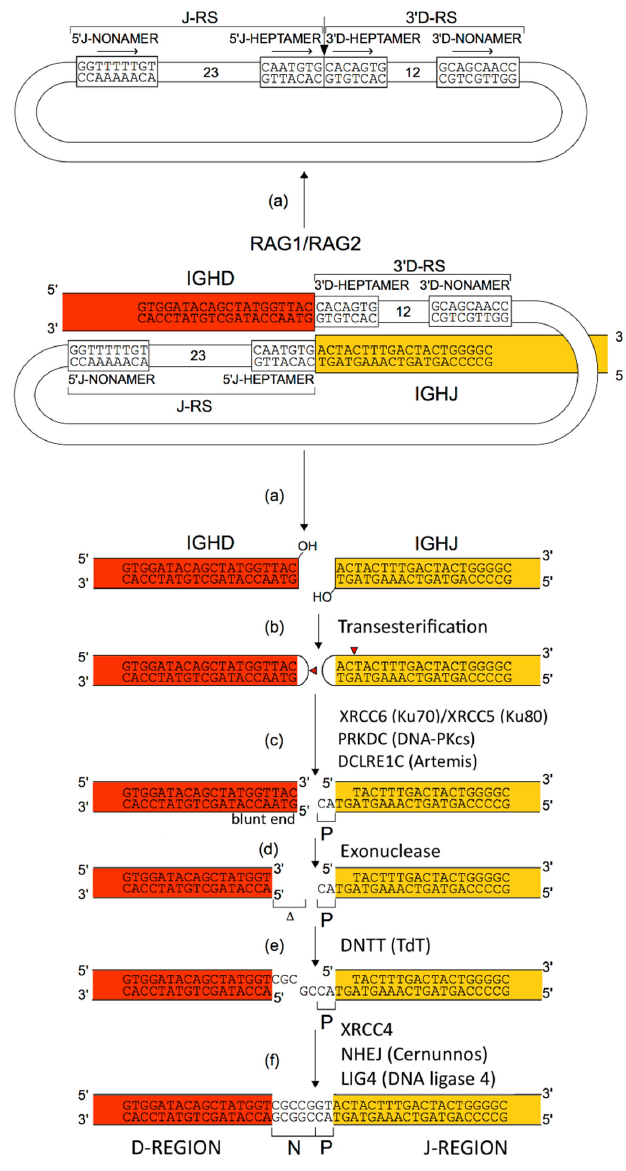
Figure 9. Molecular events generating the junction N-diversity, in a rearrangement between a D gene and a J gene in the IGH locus. ( a ) The enzymatic RAG1 / RAG2 protein complex recognizes the recombination signal (RS) sites and cuts the germline DNA between the heptamer and the coding region, resulting in a coding joint (below) and a signal joint (top) which is eliminated as an excision circle. ( b ) A hairpin is formed at each coding end, here 3 ′ D and 5 ′ J ends, by transesterification. ( c ) The haipin is cut by the protein complex (X-ray repair cross complementing 6 (XRCC6, Ku70) / X-ray repair cross complementing 5 (XRCC5, Ku80), protein kinase DNA-activated catalytic subunit (PRKDC, DNA-PKcs, DNA-PK), DNA cross-link repair 1C (DCLRE1C, Artemis). Depending on the position of the cut-o ff site, a blunt end or P nucleotides are obtained. ( d ) An exonuclease eliminates nucleotides at the coding ends. ( e ) DNA nucleotidylexotransferase (DNTT, TdT, terminal deoxynucleotidyl transferase) adds N nucleotides, preferably ‘g’ and ‘c’ at random without template. ( f ) Finally, the rearranged DNA is repaired and ends are ligated by the ligase complex (X-ray repair cross complementing 4 (XRCC4), non-homologous end joining factor 1 (NHEJ1, Cernunnos), LIG4 (DNA ligase 4, ligase IV DNA ATP-dependent). (With permission from M-P. Lefranc and G. Lefranc, LIGM, Founders